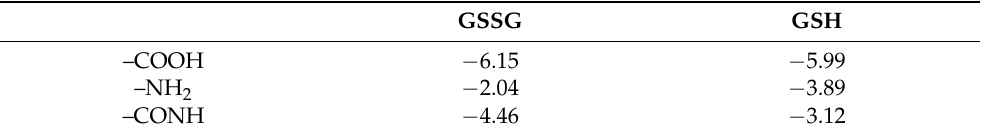
Table 2. Adsorption energies of acetonitrile on GSSG and GSH in aqueous solution (kcal/mol).